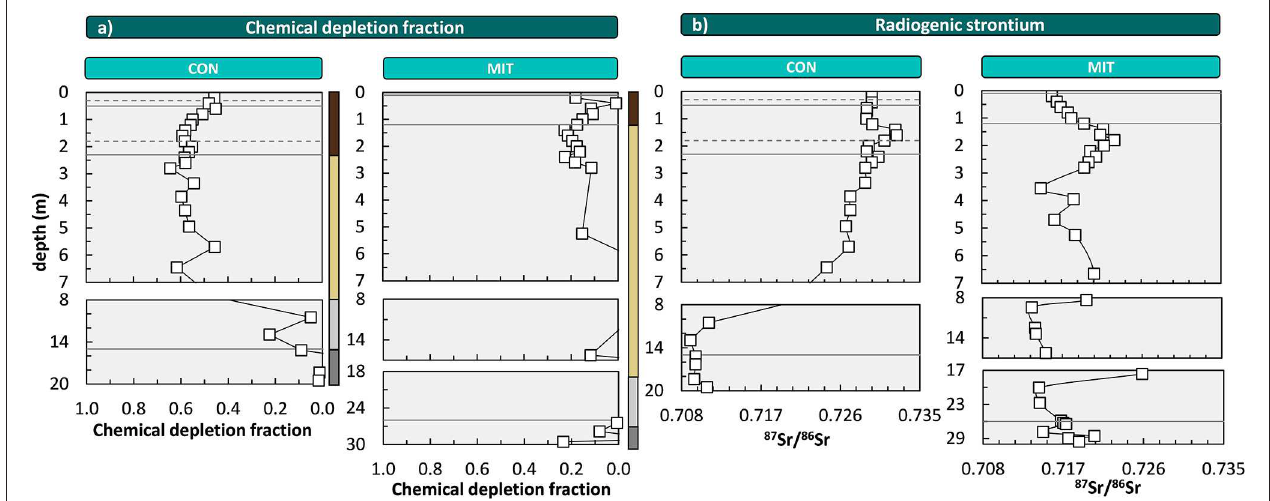
FIGURE 3 | Depth distribution of the chemical depletion fraction (CDF, a ) and the radiogenic strontium isotope ratio ( 87 Sr/ 86 Sr, b ). Solid lines illustrate soil horizon boundaries and the interface of weathered rock to unweathered rock. Dashed lines indicate soil horizon subdivision (see Figure 2 ). Colored bars at the right site of panel a refer to color coding of drill core sections from Figure 2 . For ease of display we changed the y-axis spacing with depth, yet all data are shown continuously. At MIT some CDF-values are negative; these are not displayed for